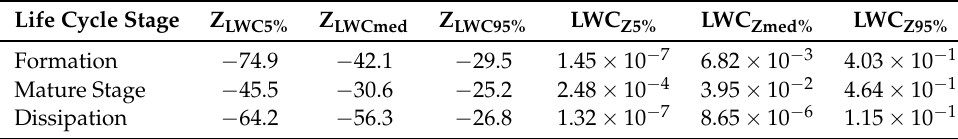
Table 5. Derived Z and LWC values of the sensitivity